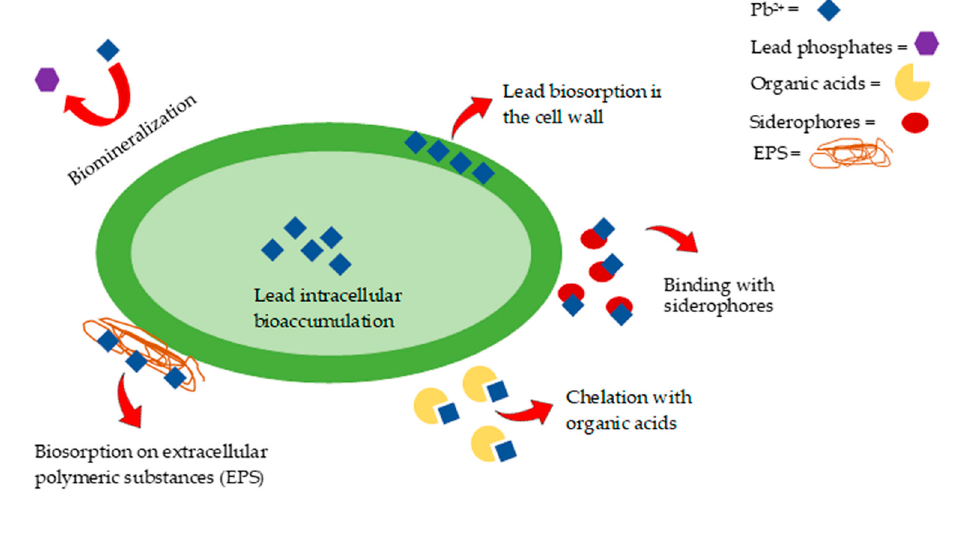
Figure 2. Schematic representation of the principal mechanisms involved in bioremediation of lead by fungi and bacteria.